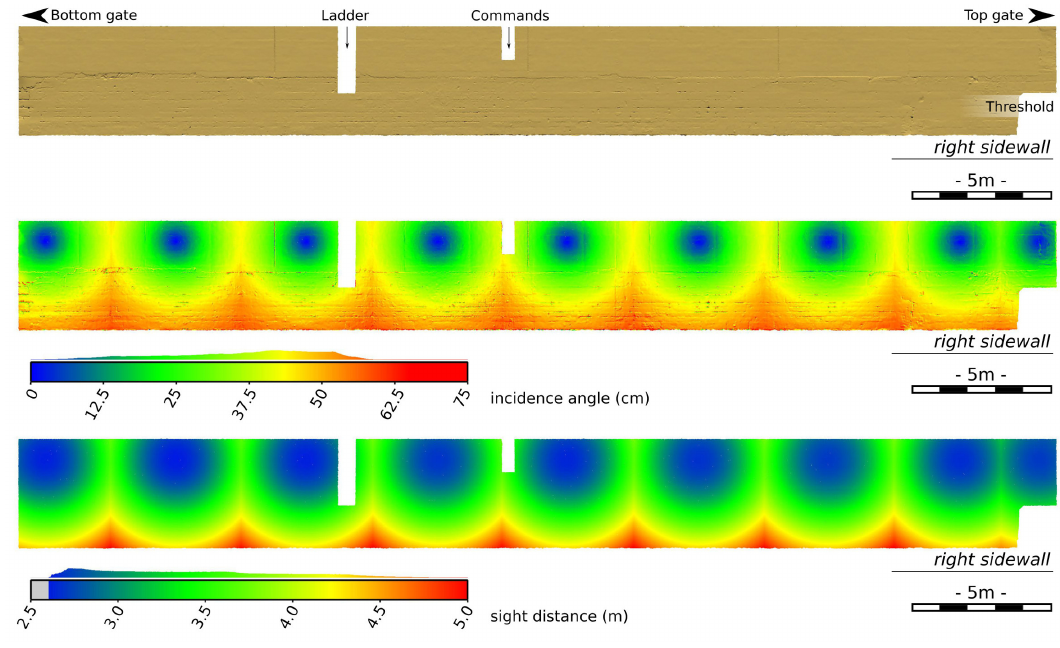
Figure 2. (a) extremity of the empty lock (near the top gate); (b) corresponding TLS model; (c) view of the ladder supporting the fixation of the MSS (pole) and a tacheometric prism (the tacheometer is visible on the background); (d) MSS model (manually processed).